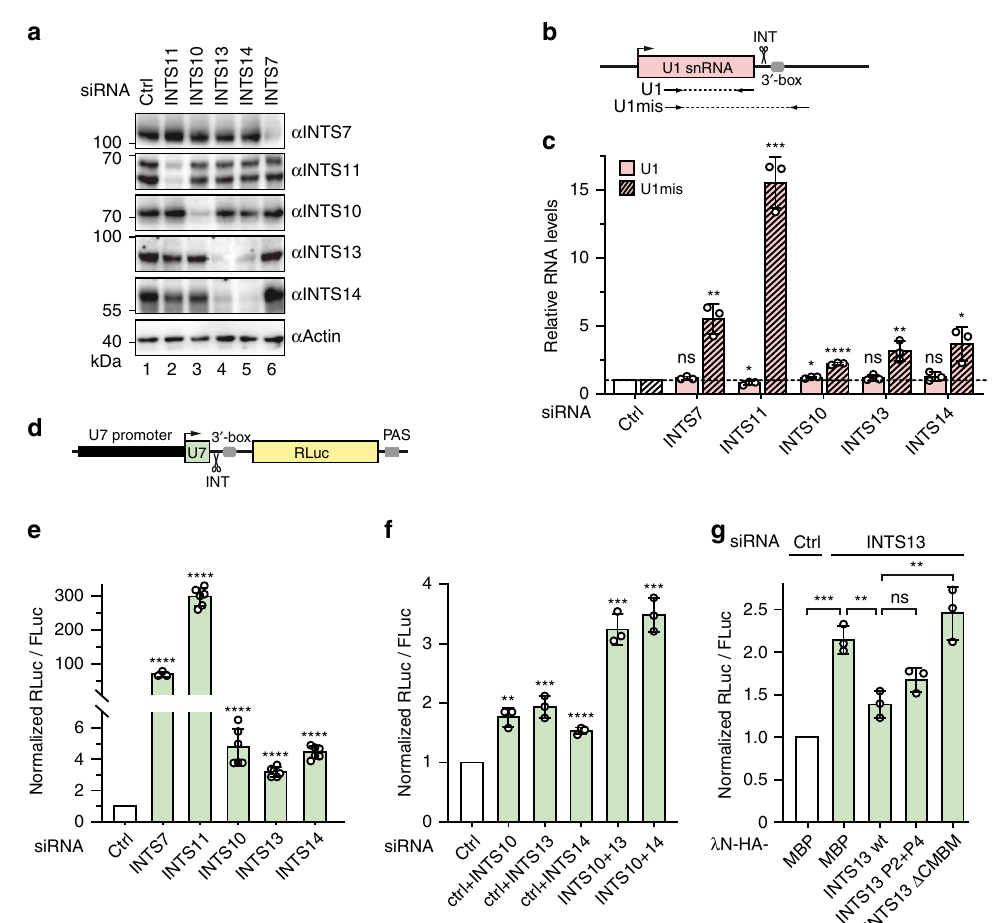
Fig. 6 The INTS10 – INTS13 – INTS14 module has an accessory role in UsnRNA processing. a Representative Western blot of cells treated with siRNAs against INT subunits or non-targeting siRNA (corresponding to Fig. 7b). Actin served as loading control. b Scheme of qPCR-binding sites for ampli fi cation of mature (U1) and misprocessed (U1mis) U1 snRNA. c Relative U1 snRNA levels as determined by RT-qPCR. Clear bars represent U1 levels, while shaded bars represent levels of U1mis. All values were determined relative to U6 snRNA, which as an RNAPIII transcript is independent of INT, and were further normalized to the control knockdown condition. Statistical signi fi cance of U1 or U1mis levels was determined relative to their respective levels in the control depletion. d Scheme of U7 luciferase reporter construct used in e – g . Impaired U7 snRNA transcript cleavage by INT at the 3 ′ -box leads to increased Renilla Luciferase (RLuc) levels. PAS polyadenylation signal. e , f Luciferase assay using the U7-reporter in cells depleted for individual INT subunits e or two INTS10 – INTS13 – INTS14 module subunits f . A plasmid expressing Fire fl y luciferase (FLuc) under control of a CMV promoter was used as transfection control. Statistical signi fi cance was determined for each knockdown relative to the control. g Rescue assays for INTS13 function in snRNA processing using the U7-reporter. Cells were treated with a control siRNA or INTS13 siRNA and transfected with HA-tagged INTS13 wt or mutants together with the reporter and FLuc transfection control. MBP served as negative control. All bar graphs depict mean values of biological triplicates shown together with individual values as dots, and error bars representing standard deviations. Statistical signi fi cance was determined by unpaired, two-tailed t -test: not signi fi cant (ns) p ≥ 0.05; signi fi cant * p ≤ 0.05, ** p ≤ 0.01, *** p ≤ 0.001, **** p ≤ 0.0001. Western blots for all experiments and immuno fl uorescence assays for INTS13 mutants are shown in Supplementary Fig. 8. Source data are provided as a Source Data fi